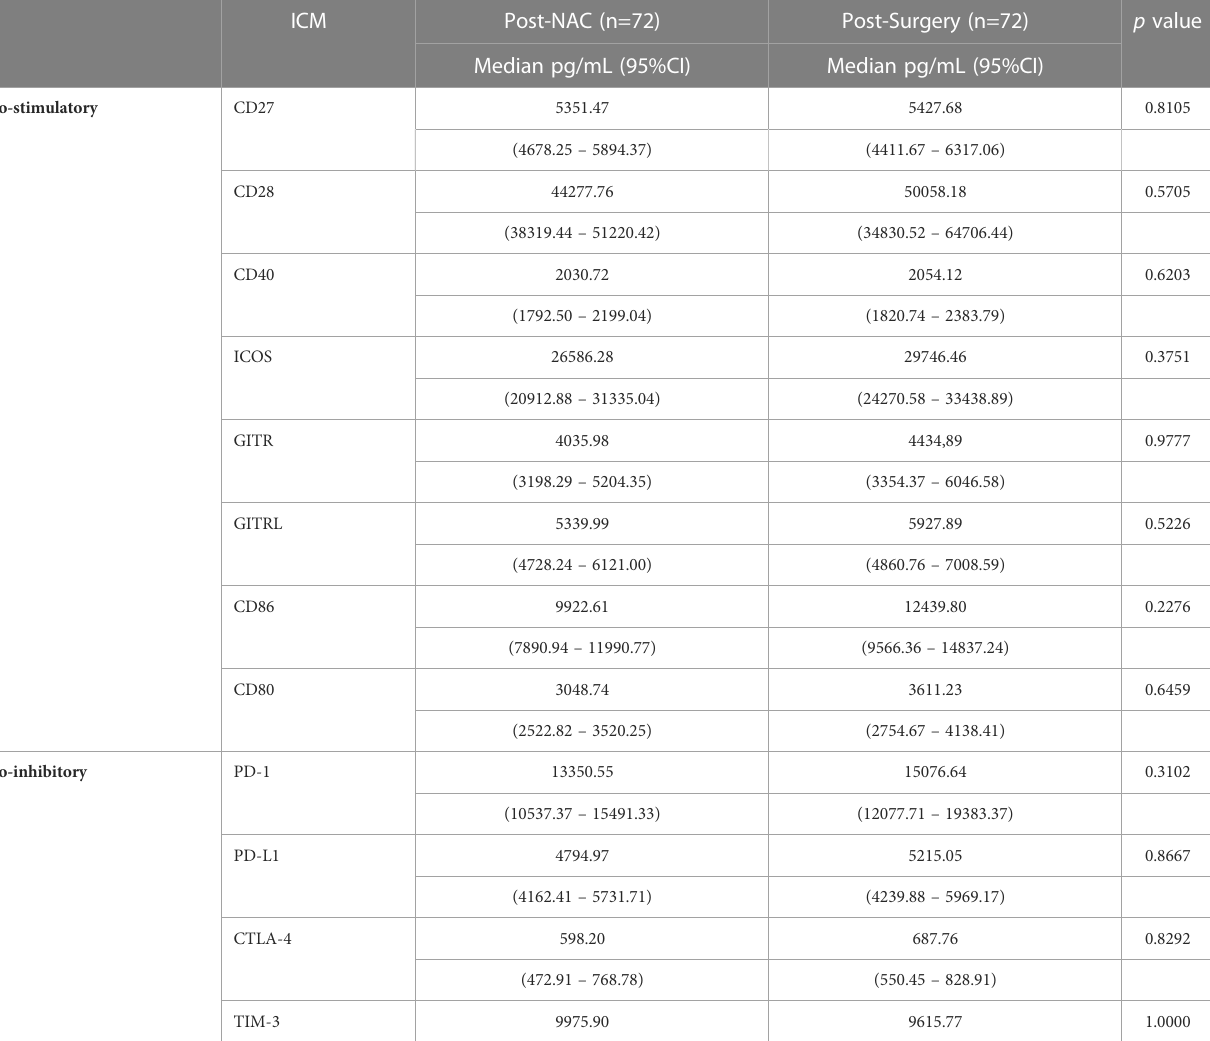
TABLE 5 Comparison of the plasma concentrations of the soluble co-stimulatory, co-inhibitory and dual-activity immune checkpoints measured in the plasma of the cohort of early breast cancer patients post-NAC and